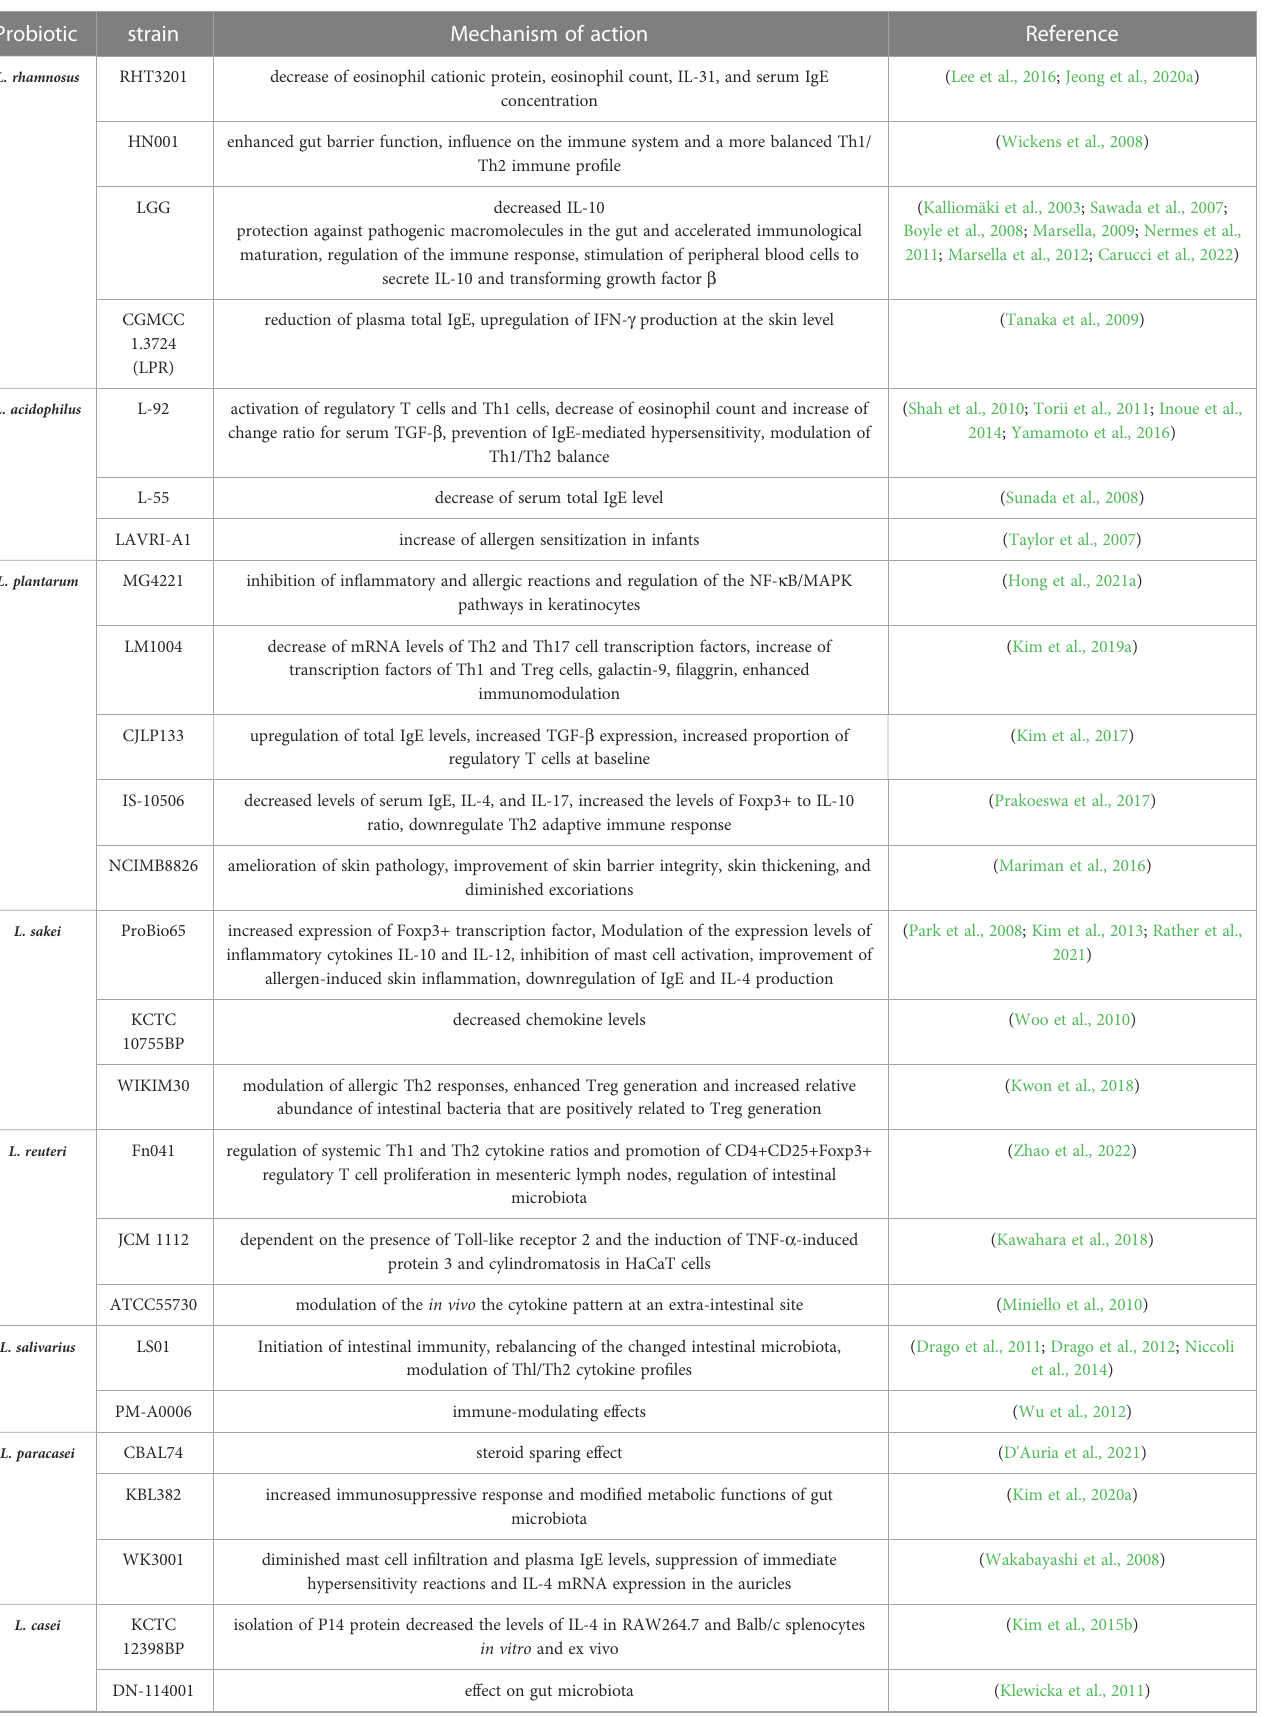
TABLE 1 Mechanism of action of Lactobacillus in the treatment of AD.